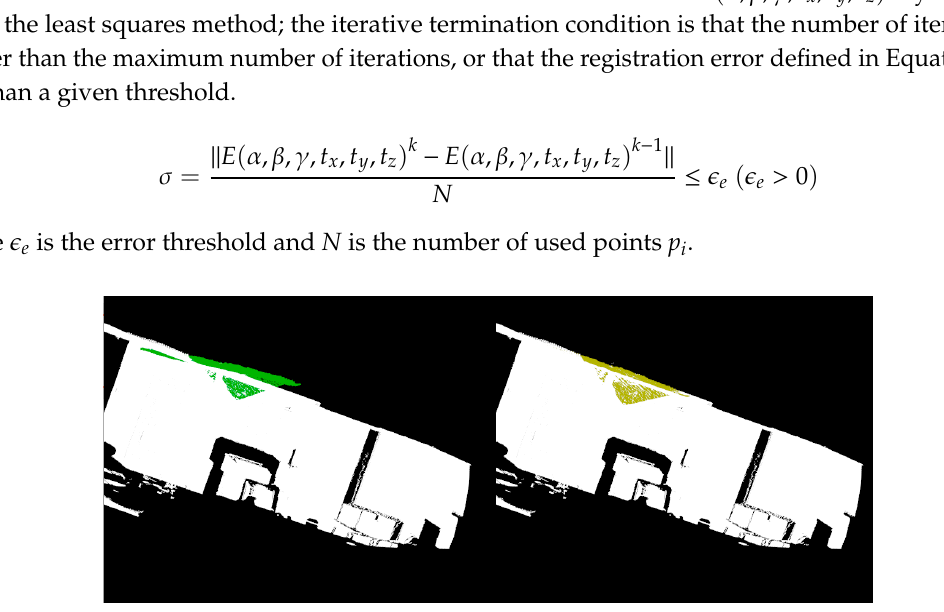
Figure 9. RGB-D point cloud generated by keyframes and LiDAR point cloud data ICP (point to plane) registration.